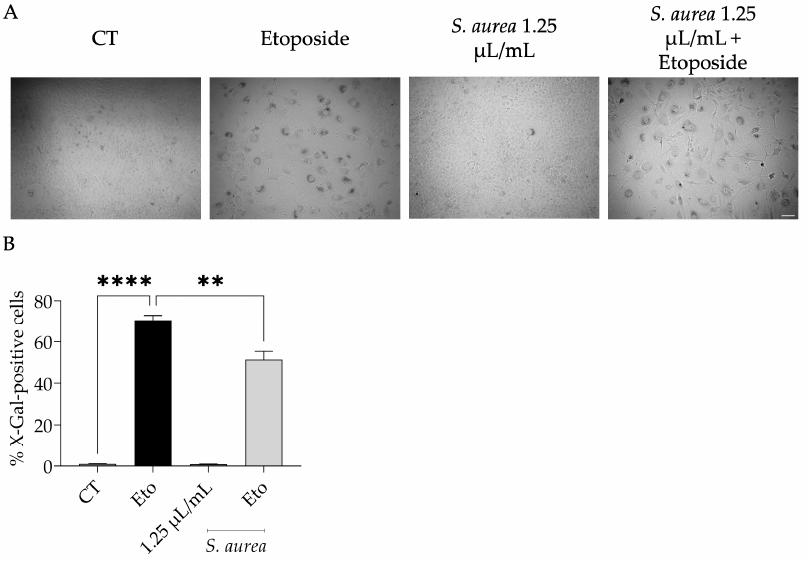
Figure 4. Effect of S. aurea EO on cell senescence. ( A ) Shows representative phase-contrast images of NIH 3T3 fibroblasts subjected to etoposide treatment (24 h etoposide incubation followed by 72 h of recovery period) in the absence (CT) or presence of S. aurea EO. ( B ) Expresses the percentage of X-gal-positive cells. Results show the mean ± SEM. Statistical significance ( ** p < 0.01, **** p < 0.0001) by control (CT) or etoposide (Eto) comparison was assessed after one-way ANOVA test and consequent Dunnett’s multiple comparison test.